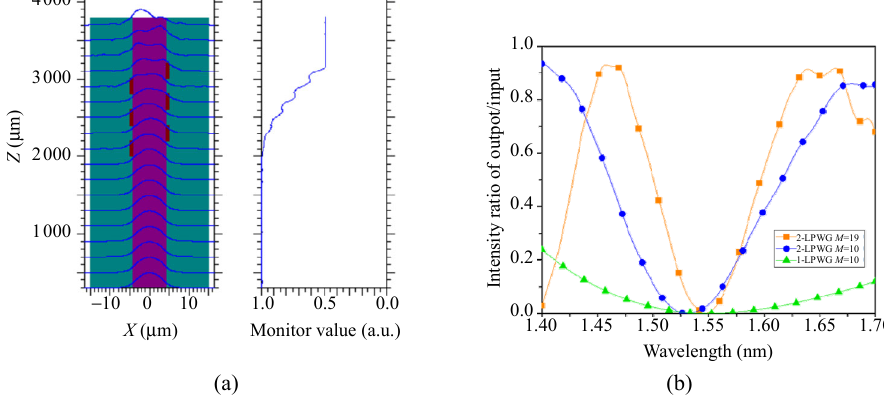
Fig. 3 Simulated transmission diagrams: (a) simulated conversion efficiency of the E 11 mode to E 21 mode at the first LPWG with 6 gratings and (b) simulated transmission spectrum. Single LPWG, M =10 (green line with triangle); cascaded-LPWGs, M =10 (blue line with circle); cascade-LPWGs, M =19 (orange line with